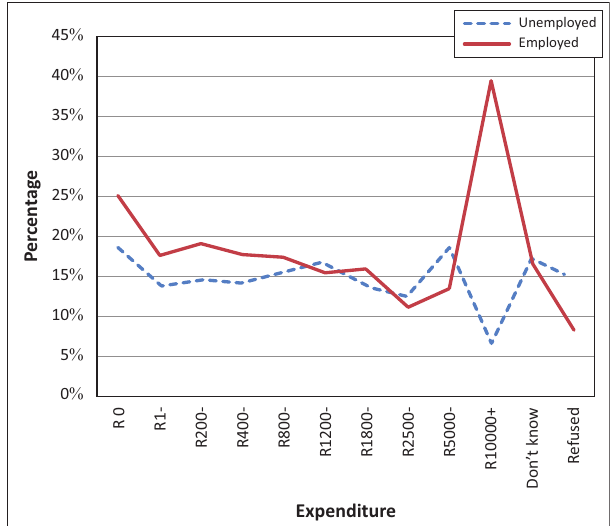
FIGURE 2: Self-reporting of vision difficulty by expenditure and employment